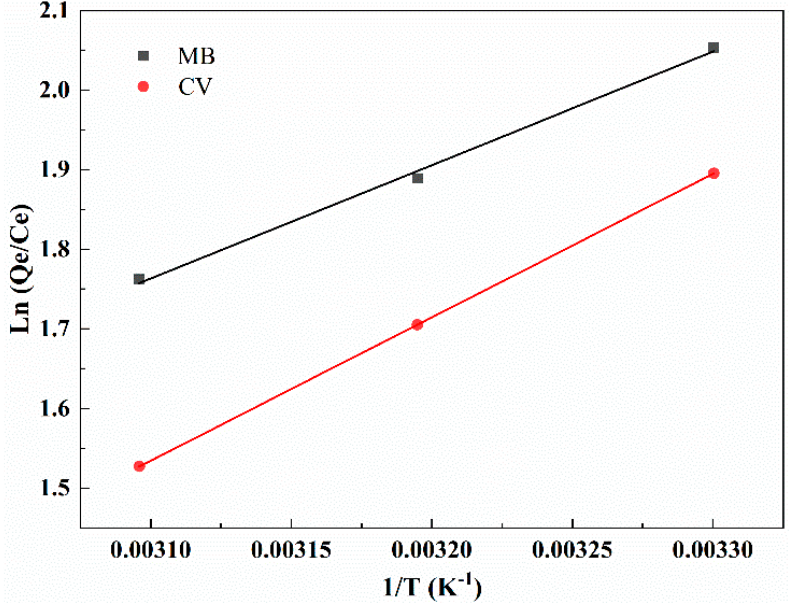
Figure 6. The van’t Hoff plot for the adsorption of MB and CV by MT. Table 5. Adsorption thermodynamic parameters for the adsorption of MB and CV by MT.